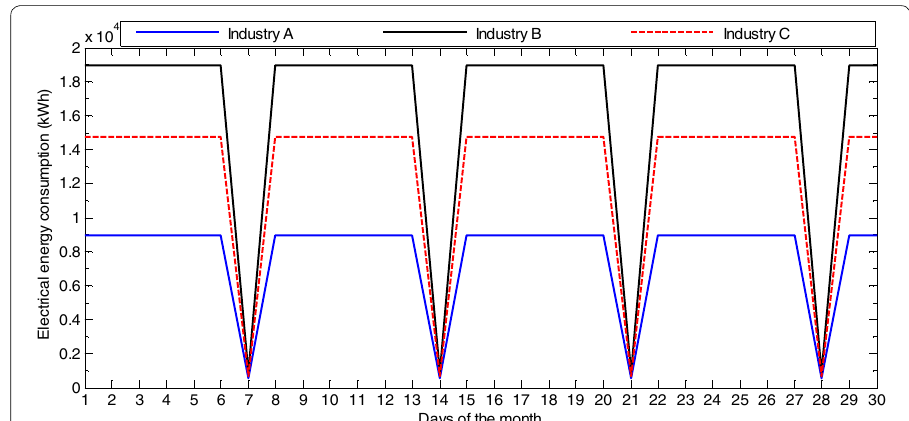
Fig. 2 Monthly load profile for the